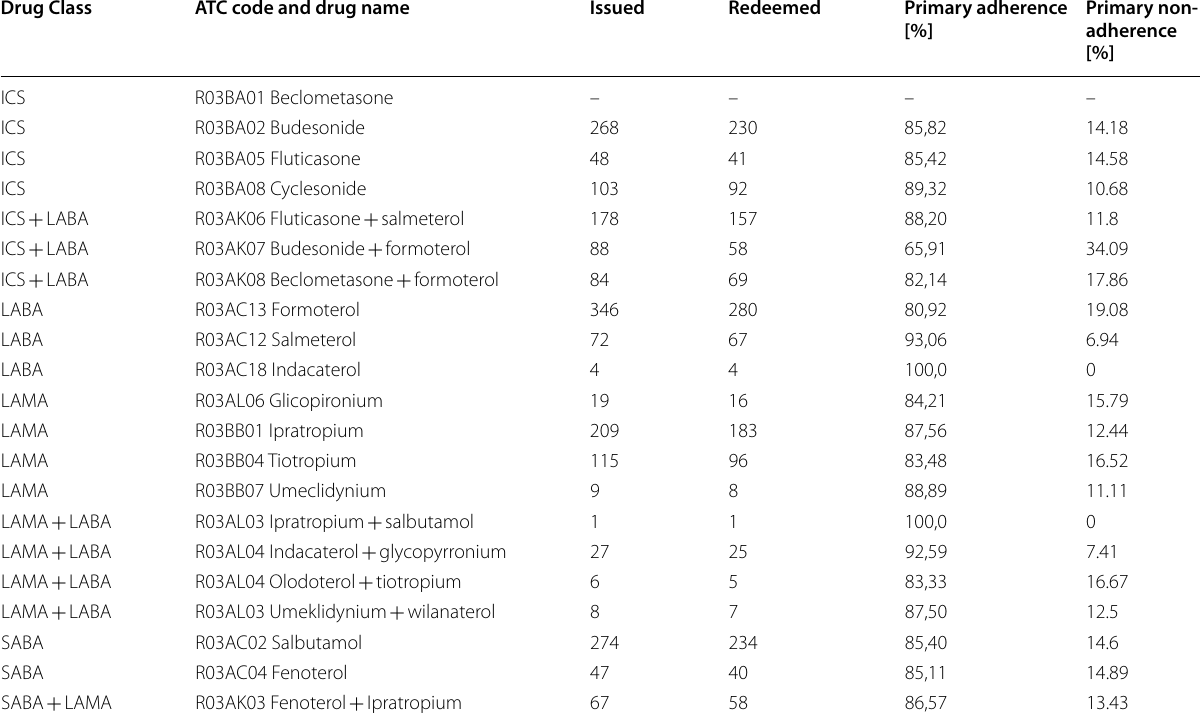
Table 4 Primary non-adherence to individual inhaled medications Drug Class ATC code and drug